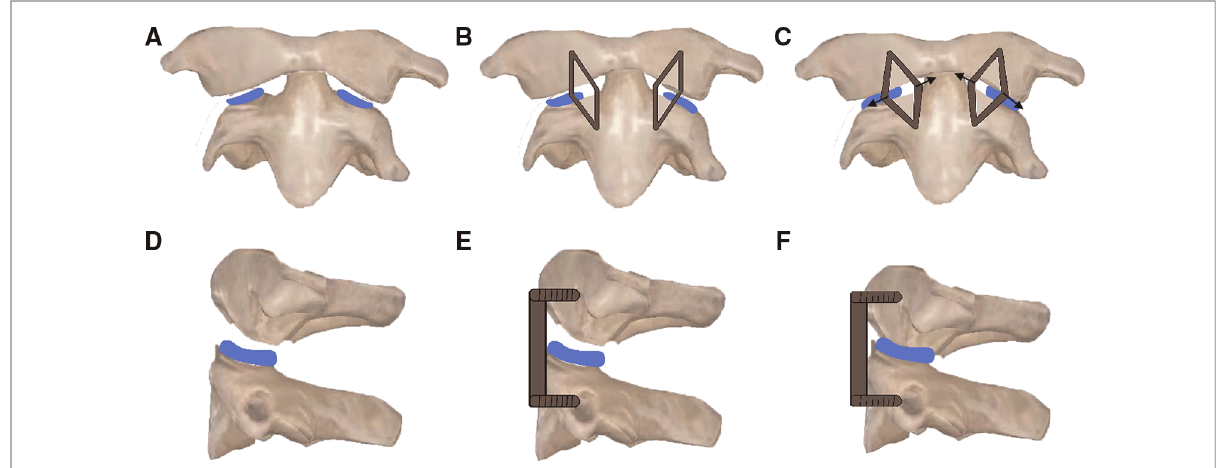
FIGURE 1 Schematic diagram of operation. ( A,D ) Two intraarticular cages were inserted into the bilateral lateral mass joints. ( B,E ) Two C-JAWS staples were fi xed to the atlantoaxial joint, with the cephalad end fi xed into the C1 lateral mass and the caudal end fi xed into the C2 vertebral body. ( C,F ) Two C-JAWS staples were spreaded to both sides to produce compression on